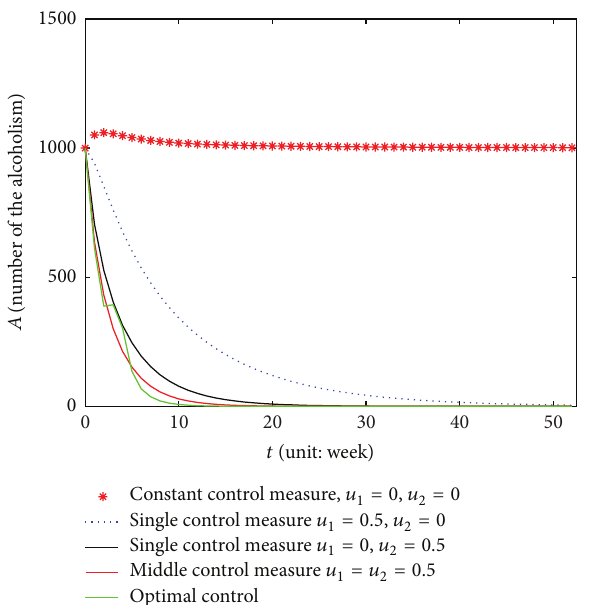
Figure 6: Number of the alcoholics when we choose the weights in objective function are 𝑐 1 = 10 2 ; 𝑐 2 = 10 4 and under different optimal control strategies, that is, (1) without control: 𝑢 1 = 𝑢 2 = 0 ; (2) single control: 𝑢 1 = 0.5 , 𝑢 2 = 0 ; (3) single control: 𝑢 1 = 0 , 𝑢 2 = 0.5 ; (4) middle control: 𝑢 1 = 𝑢 2 = 0.5 ; (5) optimal control: 𝑢 1 = 𝑢 ∗ 1 , 𝑢 2 = 𝑢 ∗ 2 .